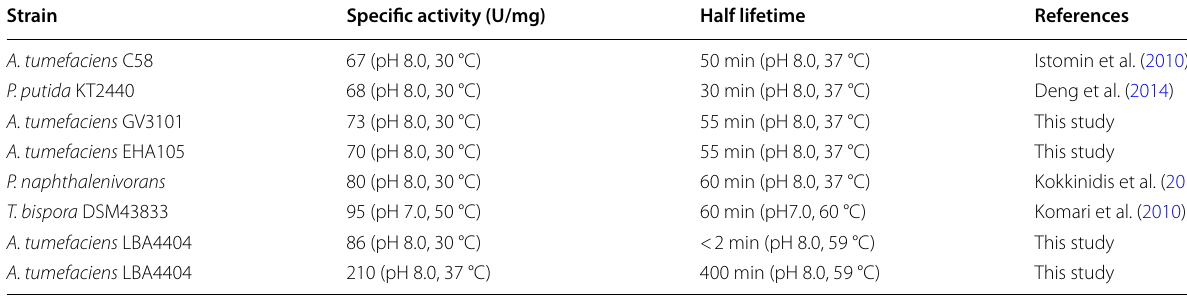
Table 3 Comparison of enzymatic properties of characterization UDH